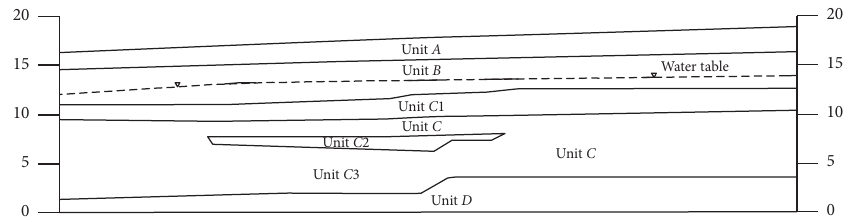
Figure 8: Soil profile of the Wynne Street after Holzer et al.